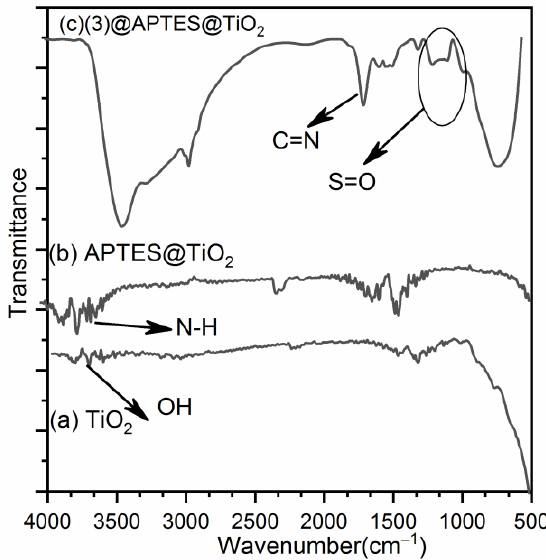
Figure 9. Comparative IR spectra of the ( a ) TiO 2 , ( b ) APTES@TiO 2 and ( c ) (3) @APTES@TiO 2.